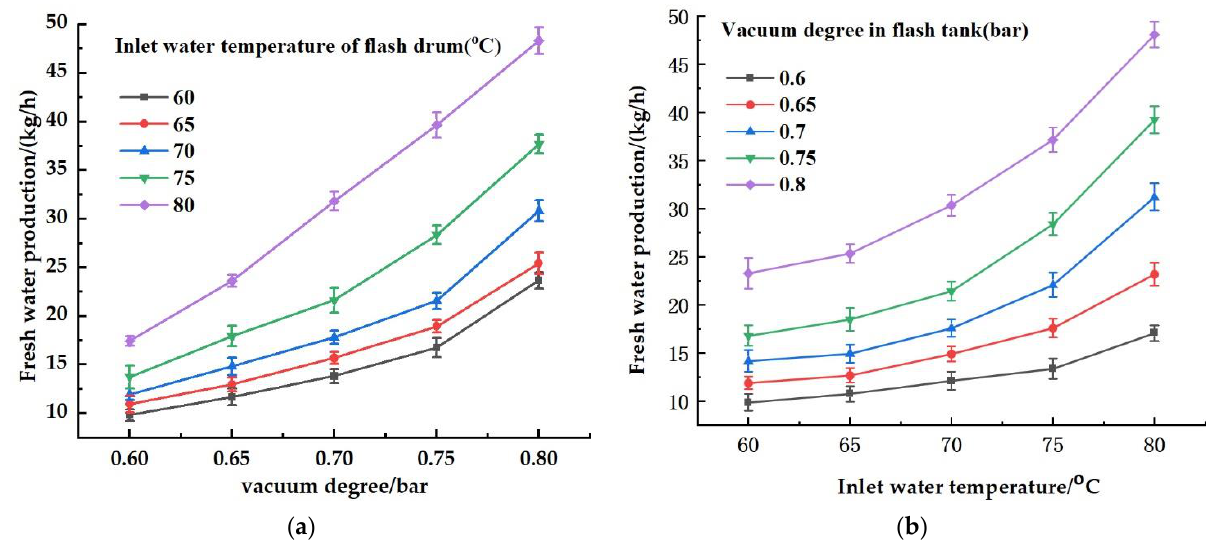
Figure 4. Effects of different temperatures and vacuums on freshwater output in the flash tank: ( a ) Inlet water temperature of the flash drum; ( b ) vacuum degree in the flash tank.